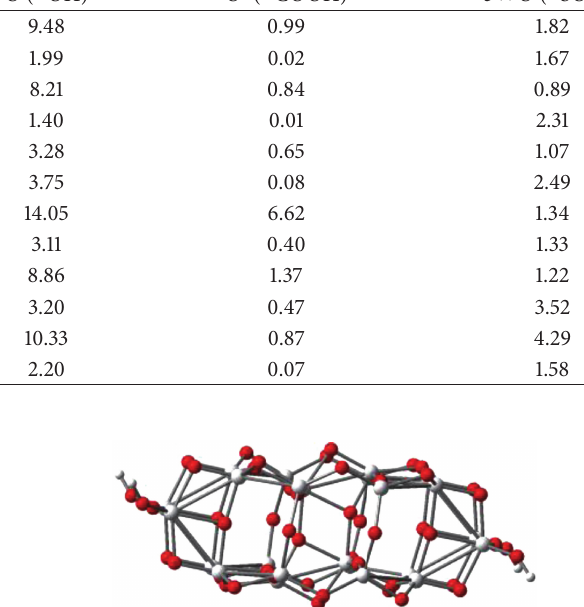
H group, considered 3 H) 3